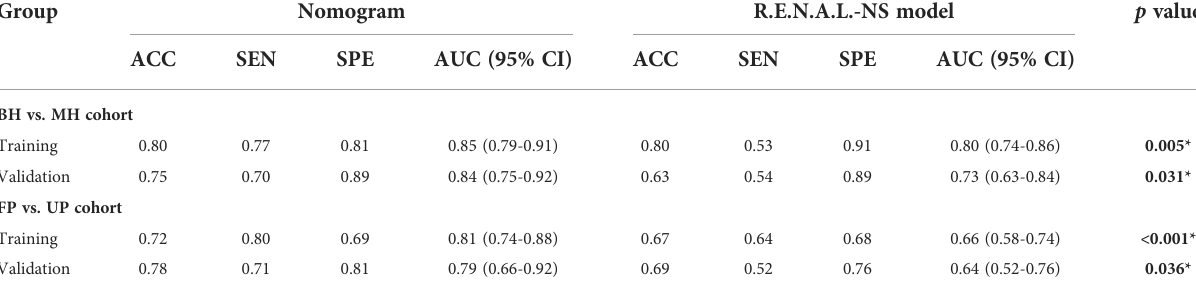
TABLE 4 Predictive performance outcomes of the nomogram and R.E.N.A.L.-NS. Group